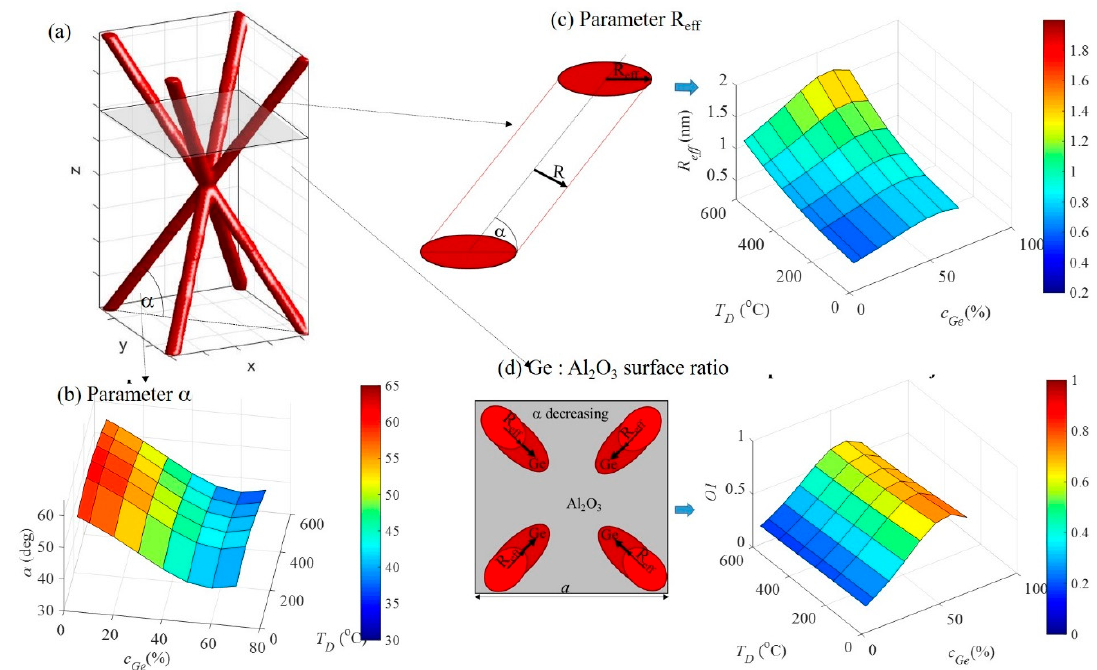
Figure 5. ( a ) Scheme of the QW network unit cell and parameters important for understanding its geometrical properties including tilt-angle α and parallel to surface cross-section of the QWs. Dependence of ( b ) tilt angle α , ( c ) QW effective radius ( R eff ), and ( d ) Ge:alumina surface ratio, on the deposition parameters.